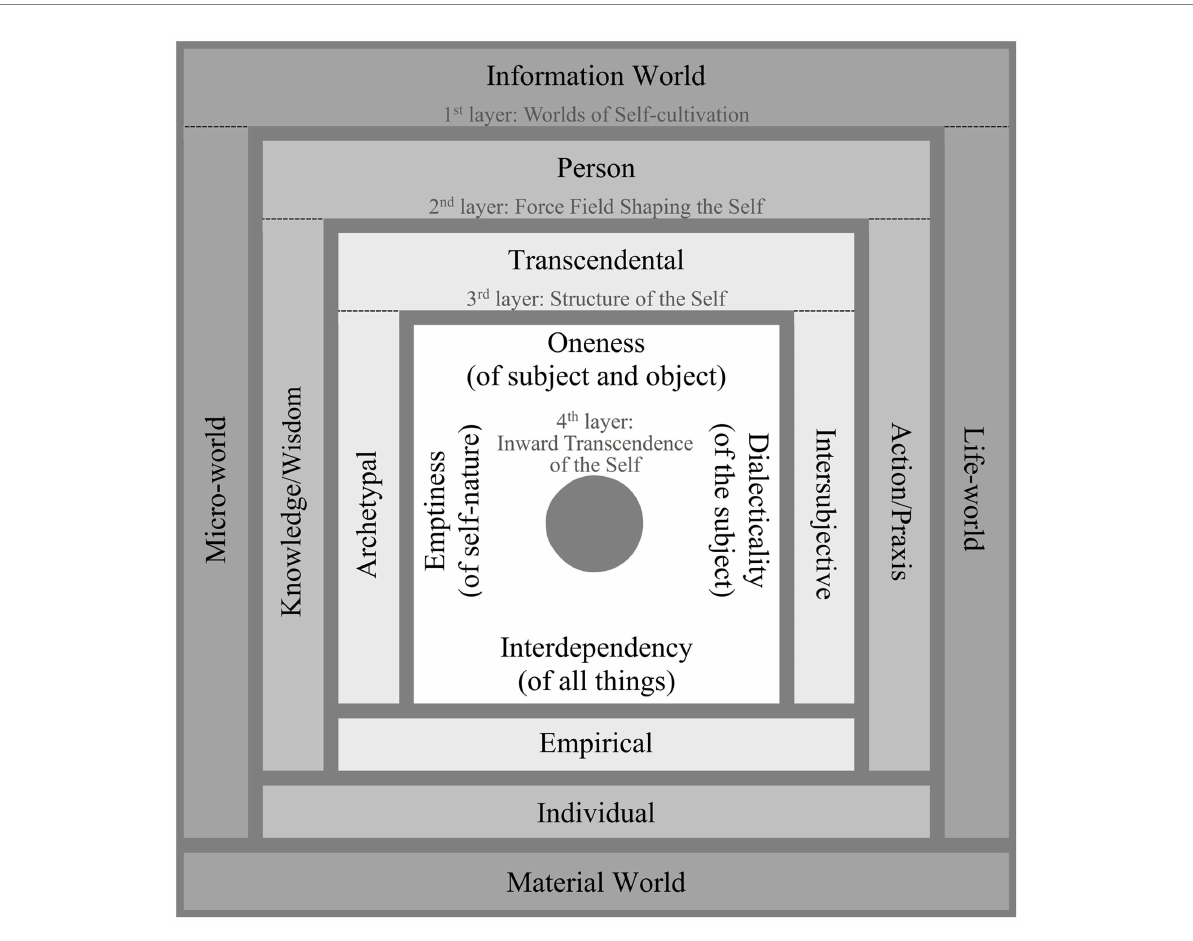
FIGURE 1 The Dialectical Mandala Model of